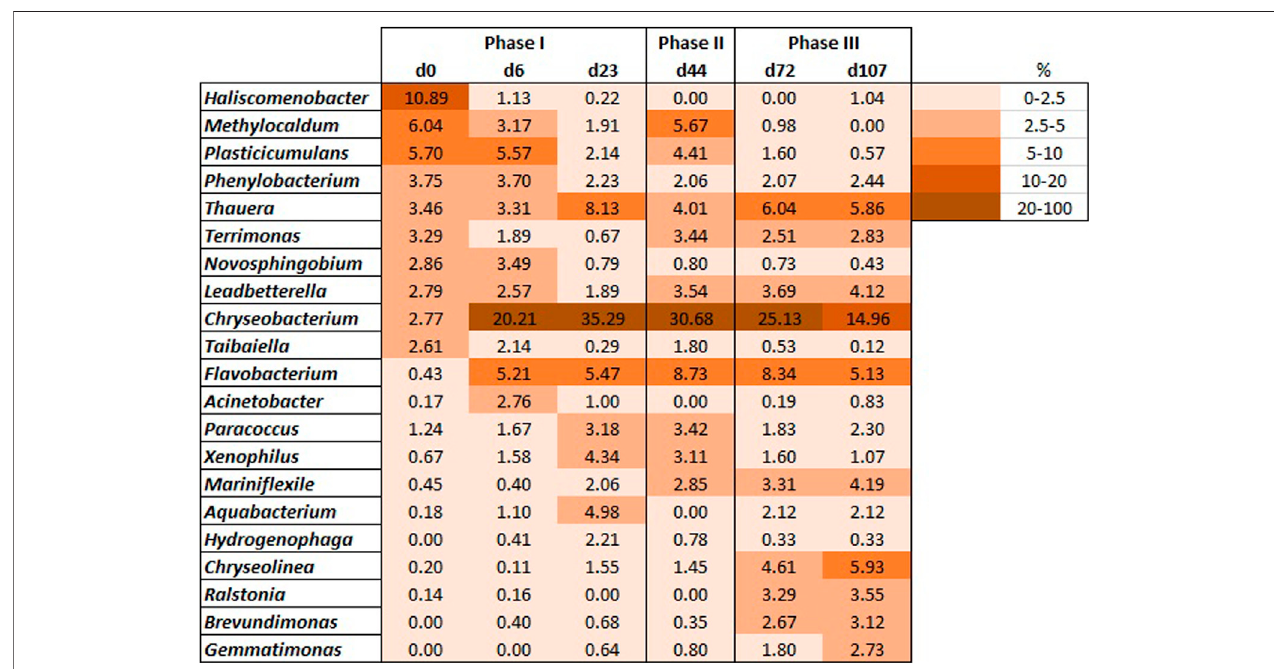
FIGURE 5 | Heatmap presenting the evolution in dominant bacterial genera in the AGS biomass along the reactor operational phases, considering the fi rst twelve dominant bacterial genera from each biomass sample.